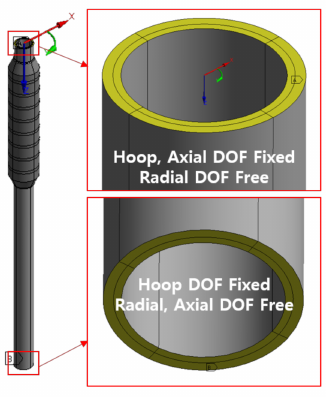
Figure 12. Constraint